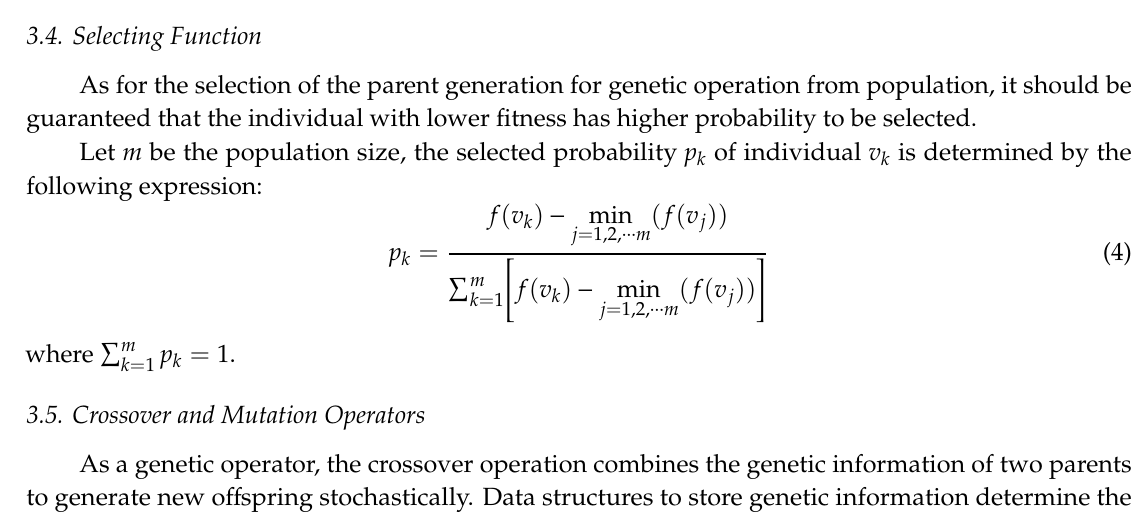
Figure 1. A float-coding chromosome for solution with 5 variables.